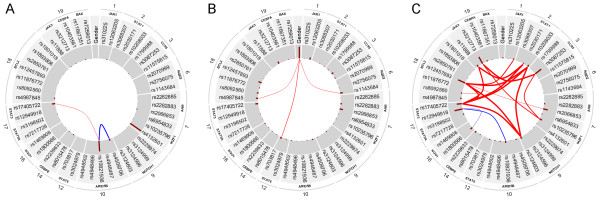
Redundancies and interactions according to the BN-BMLA method. The figure shows the magnitude of redundancies (blue curved lines) and interactions (red curved lines) between the variables in the whole dataset (i.e. ALL susceptibility, A panel), in the T-cell lineage sample group (B panel) and in the hyperdiploid sample group (C panel) according to the BN-BMLA method. See Methods for the computation of interaction and redundancy. The width of the curved lines is proportional to the strength of the effect. The a posteriori probability of the strong relevance of the variables is proportional to the length of the dark red columns next to the variable in the inner gray colored ring. The corresponding genes and chromosomes of the SNPs are shown on the outer ring.